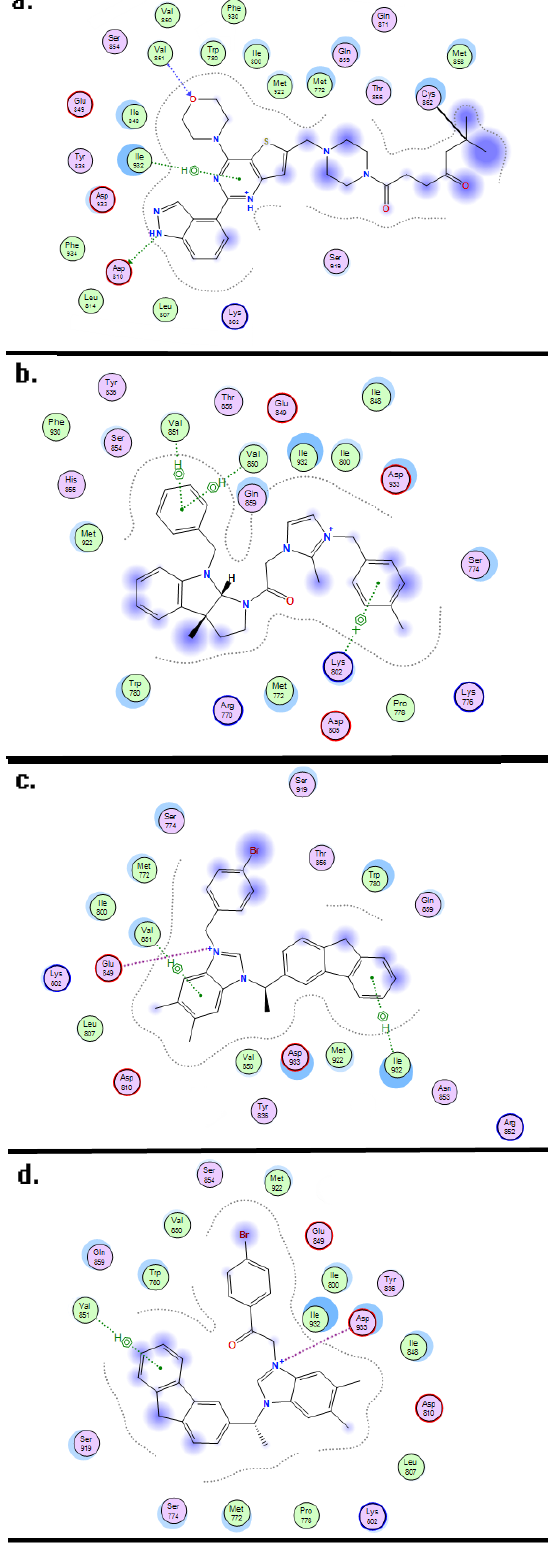
Figure 5. Molecular Dock interaction of CNX-1351 ( a ) and compounds 04 ( b ), 72 ( c ) and 74 ( d ) with the amino acids in the active pocket of protein